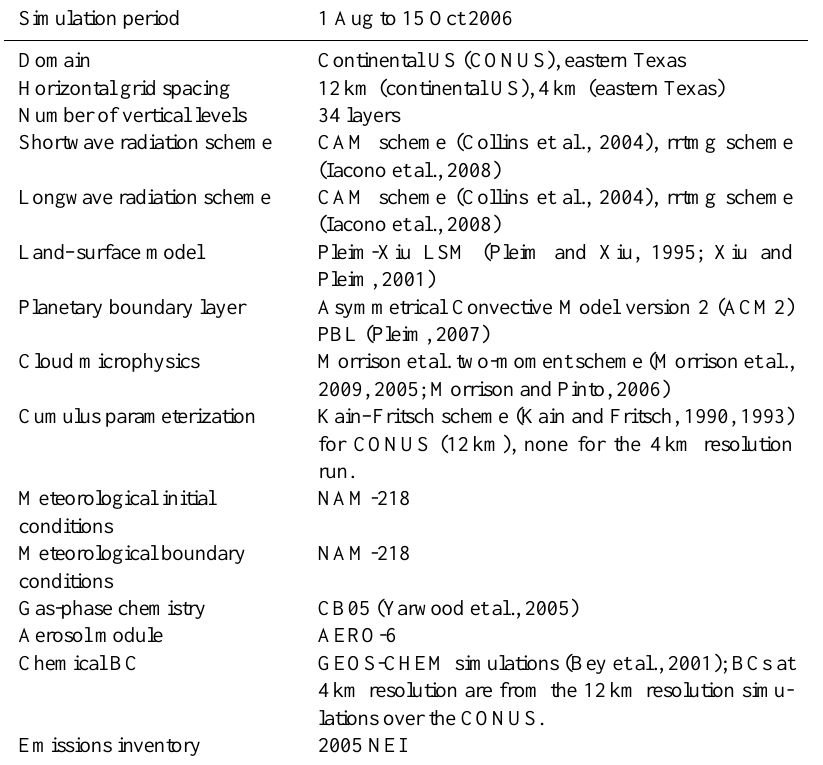
Table 1. Model configurations and components.